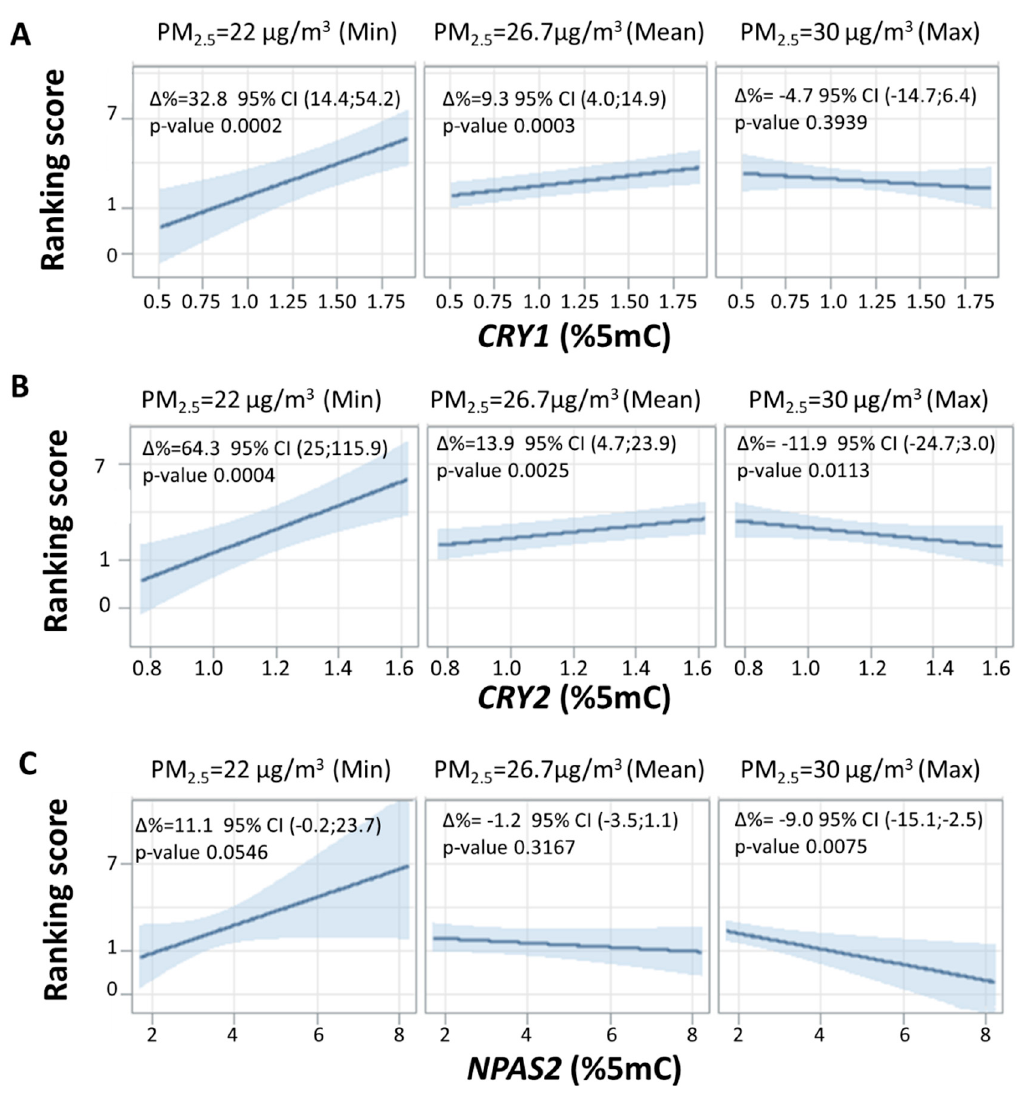
Figure 3. Interaction e ff ect of PM 2.5 annual average and clock gene methylation on Modified Rankin Scale for Neurological Disability. Strength of association between clock gene methylation and Rankin score on natural logarithmic scale at three selected levels of annual average PM 2.5 (min, mean, and max). Panels ( A – C ) represent CRY1 , CRY2 , and NPAS2 , respectively. For all panels, ∆ % is equal to (exp( β / 10)–1) × 100 and represents the percentage increase in Rankin score for 0.15mC% increment in CRY1 / CRY2 / NPAS2 methylation at each concentration of annual average PM 2.5 . Linear regression models were adjusted for age, sex, smoking habits, therapy, diabetes, hypertension, plate, and warm/cold months (months with heaters switched on/off).